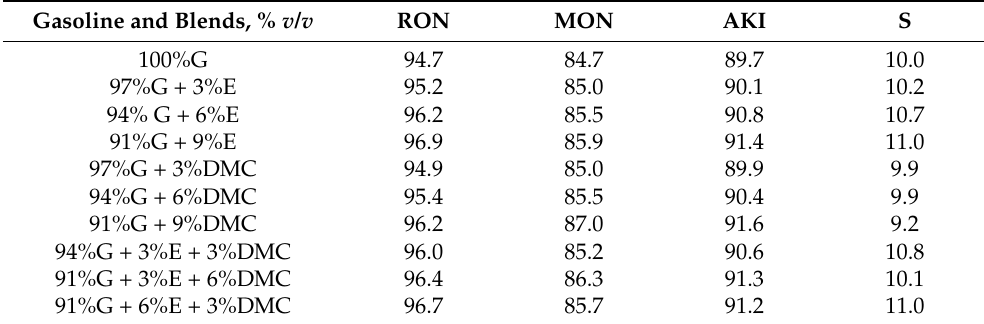
Table 5. Antiknock properties of gasoline and its blends. Gasoline and Blends, % v /